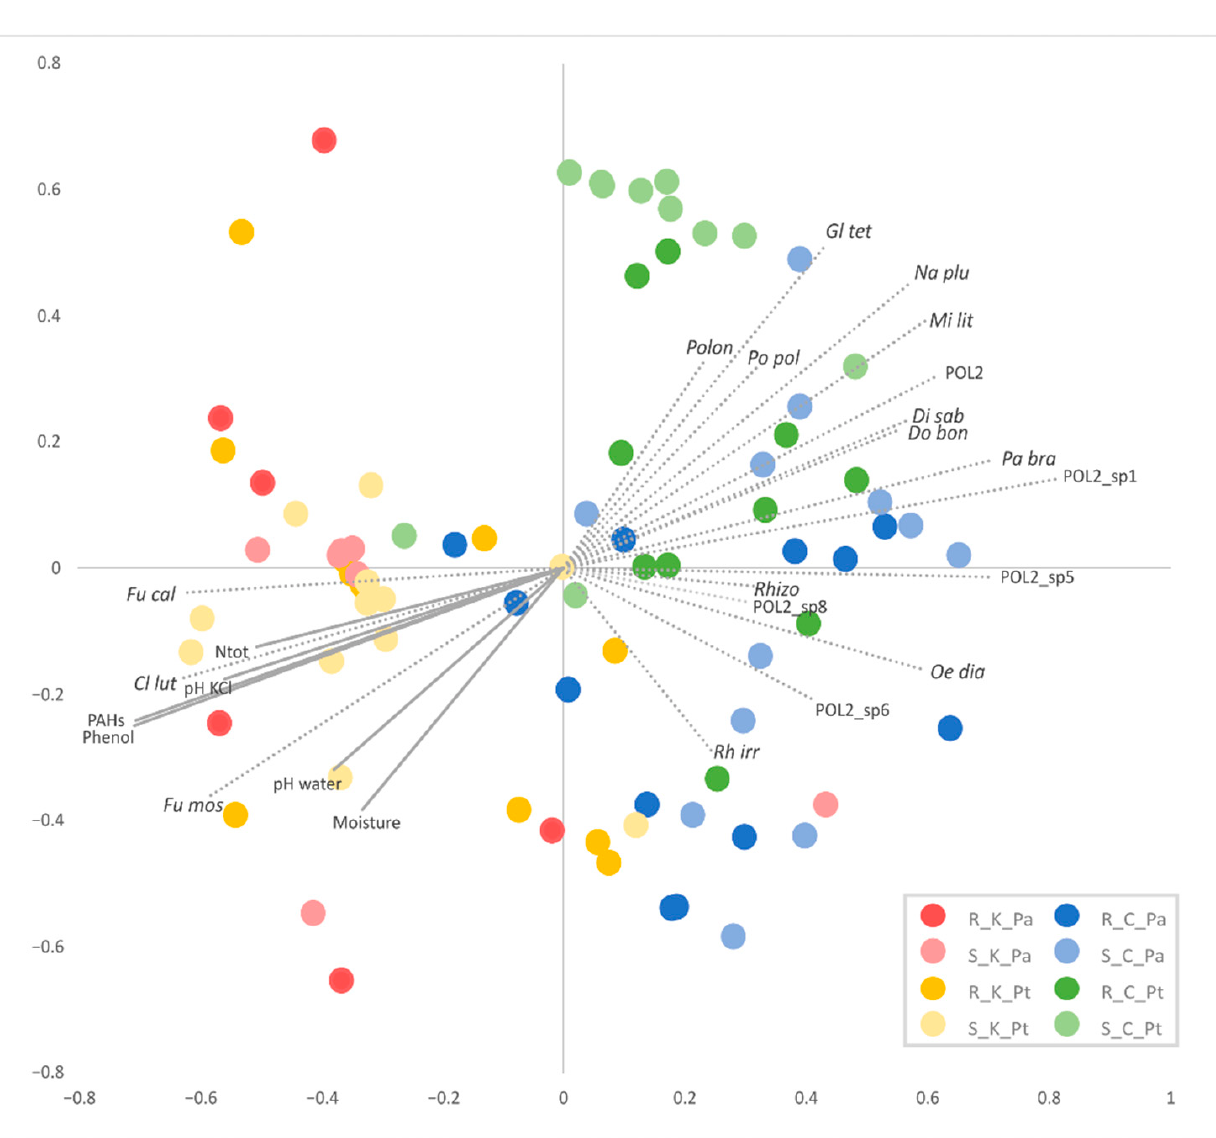
Figure 3. NMDS ordination based on the Yue and Clayton dissimilarity measure between the soil (S) and root (R) AMF communities associated with P. trivialis (Pt) and Ph. australis (Pa) collected from the contaminated (K) and uncontaminated (C) sites. Plot vectors indicate strength and direction of significant correlation ( p < 0.05) between the concentrations of phenol and PAHs in soil, soil physicochemical features and the most representative AMF species. Species abbreviations: Cl lut—